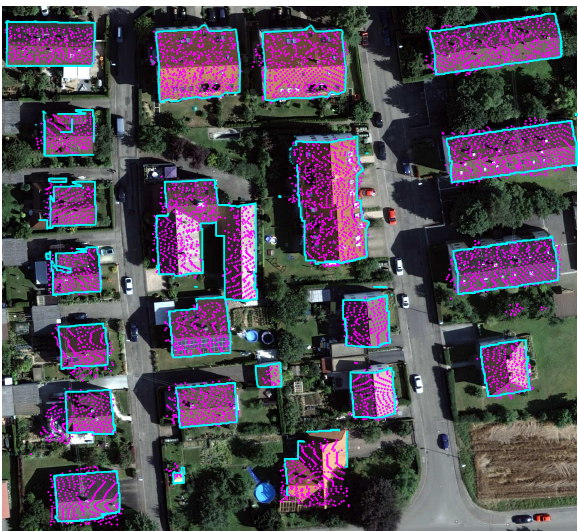
Figure 6: The overlap view of shading DSM and aerial image is